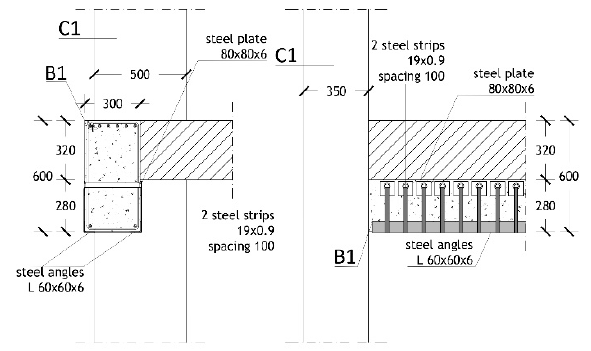
Figure 21. Web ACM-strengthened beam.